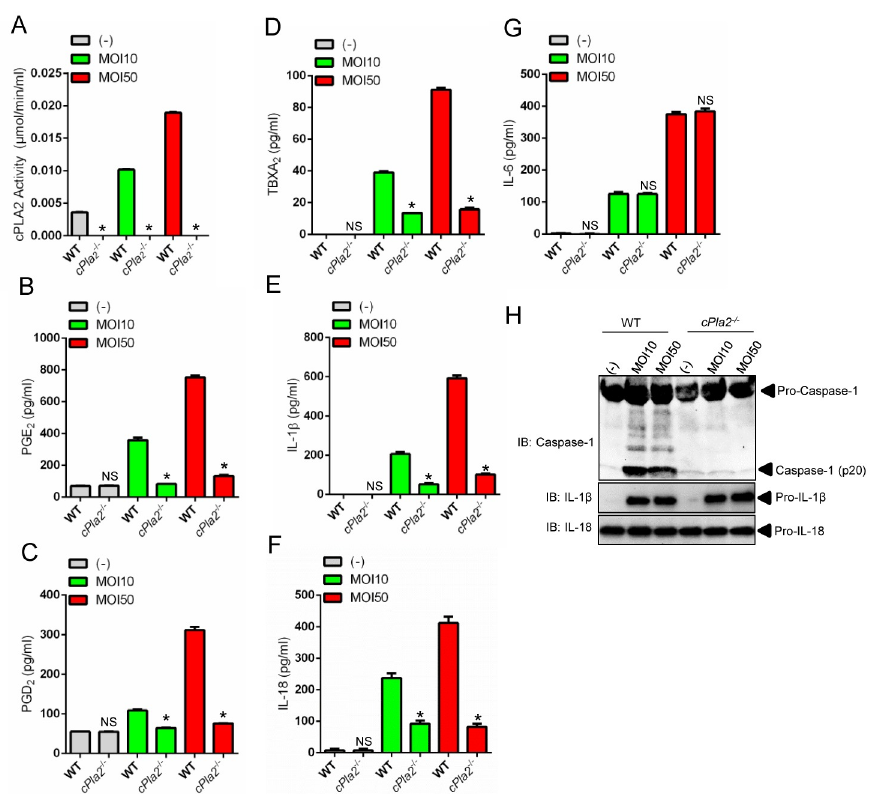
Fig 3. cPLA 2 regulates the A . phagocytophilum -induced NLRC4 inflammasome. BMDMs (1 x10 6 cells) from wildtype (WT) or cPLA 2 -deficient mice were infected with A . phagocytophilum (MOI 10/50) for 18 hours. (A) cPLA 2 enzymatic activity was measured. Release of (B) PGE 2 , (C) PGD 2 , (D) TBXA 2, (E) IL-1 β , (F) IL-18 and (G) IL-6 were measured by ELISA in the cell culture supernatants. (H) SDS-PAGE immunoblot (IB) of caspase-1 (p20) in the supernatants. pro-IL-1 β and pro-IL-18 were detected in cell lysates. Student ’ s t test. * P < 0.05. NS – not significant. (-)